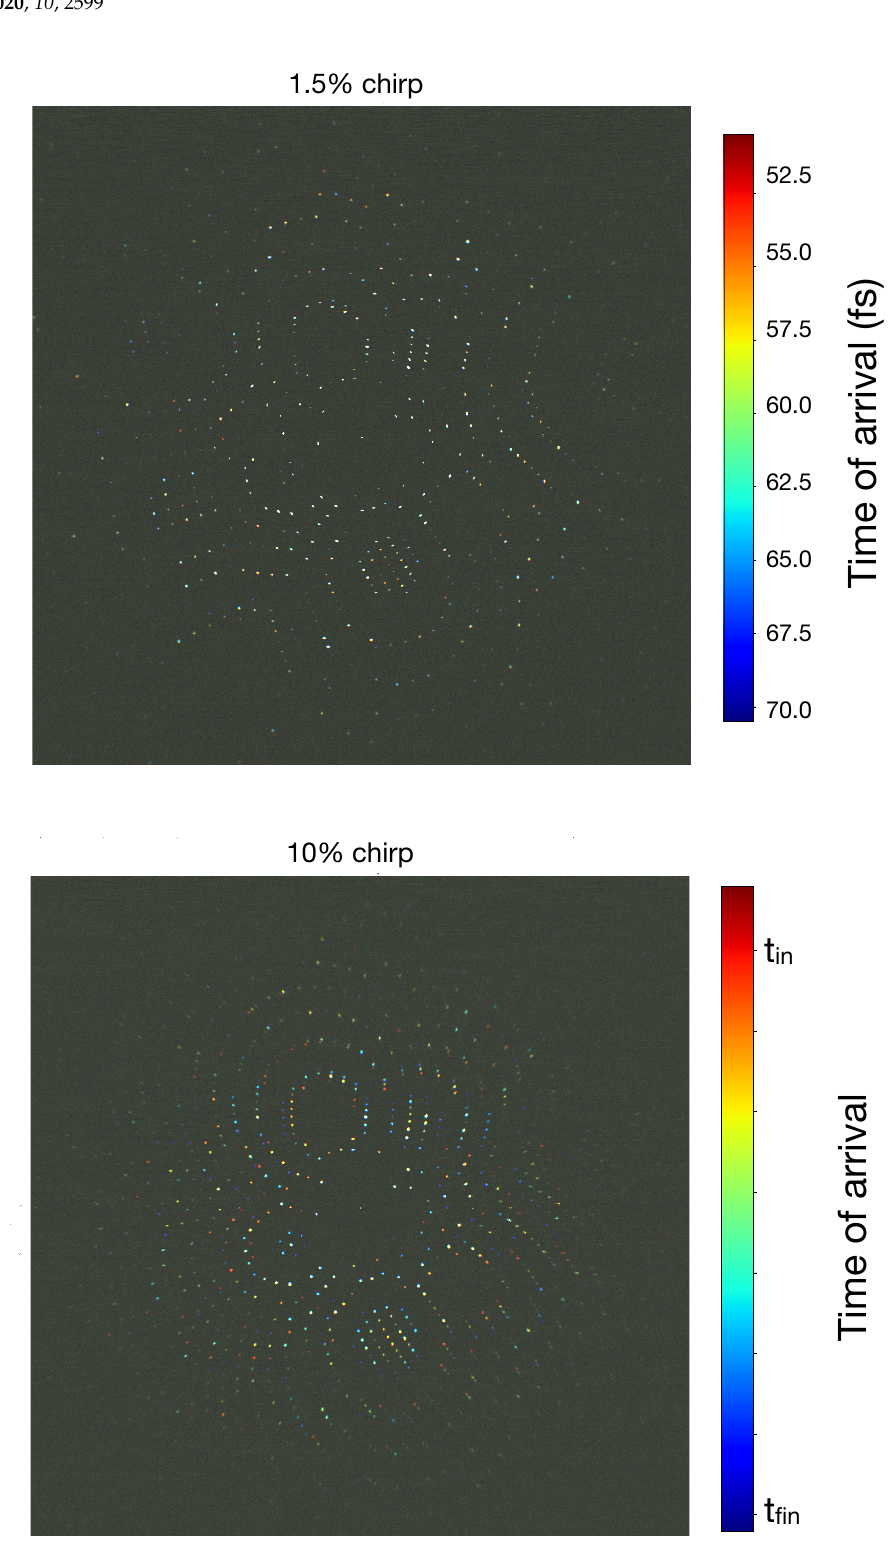
Figure 7. Chirped pulse diffraction. Simulated diffraction patterns for the central 20-fs of the SwissFEL pulse and for a hypothetical 10% chirp. Different energy contributions are colored based on their time of arrival for the smaller chirp. As a simulation for 10% chirp at SwissFEL is not available, the streaking effect is shown without specific time assignments. The simulated diffraction extends to a resolution of 1.5